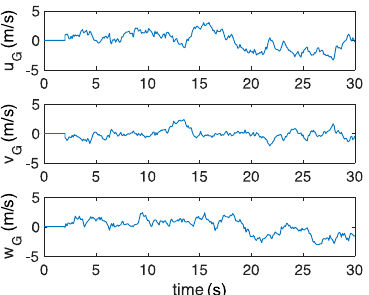
Figure 11. Dryden wind turbulence velocities.